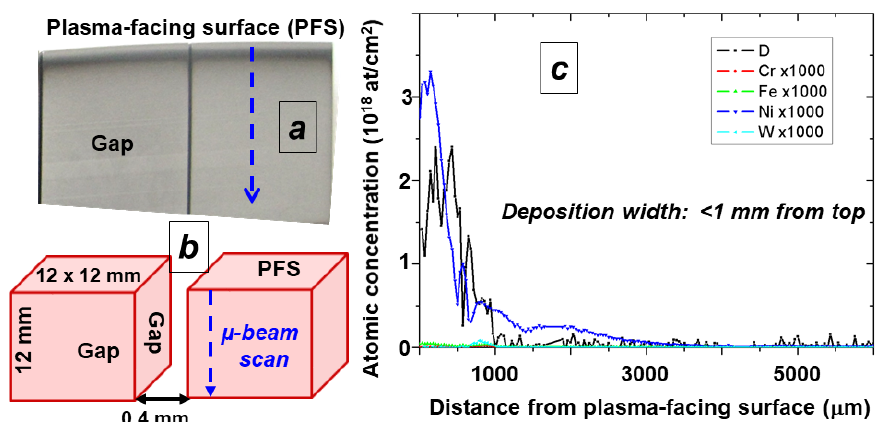
Figure 5. Deposition inside castellated Be limiters from JET-ILW: ( a ) side surface of the castellation with a narrow deposition belt at the entrance to the gap; ( b ) schematic view of a castellated structure; ( c ) deposition profiles of D and metals in the castellation; note the plotted metal contents are magnified by a factor of 1000.